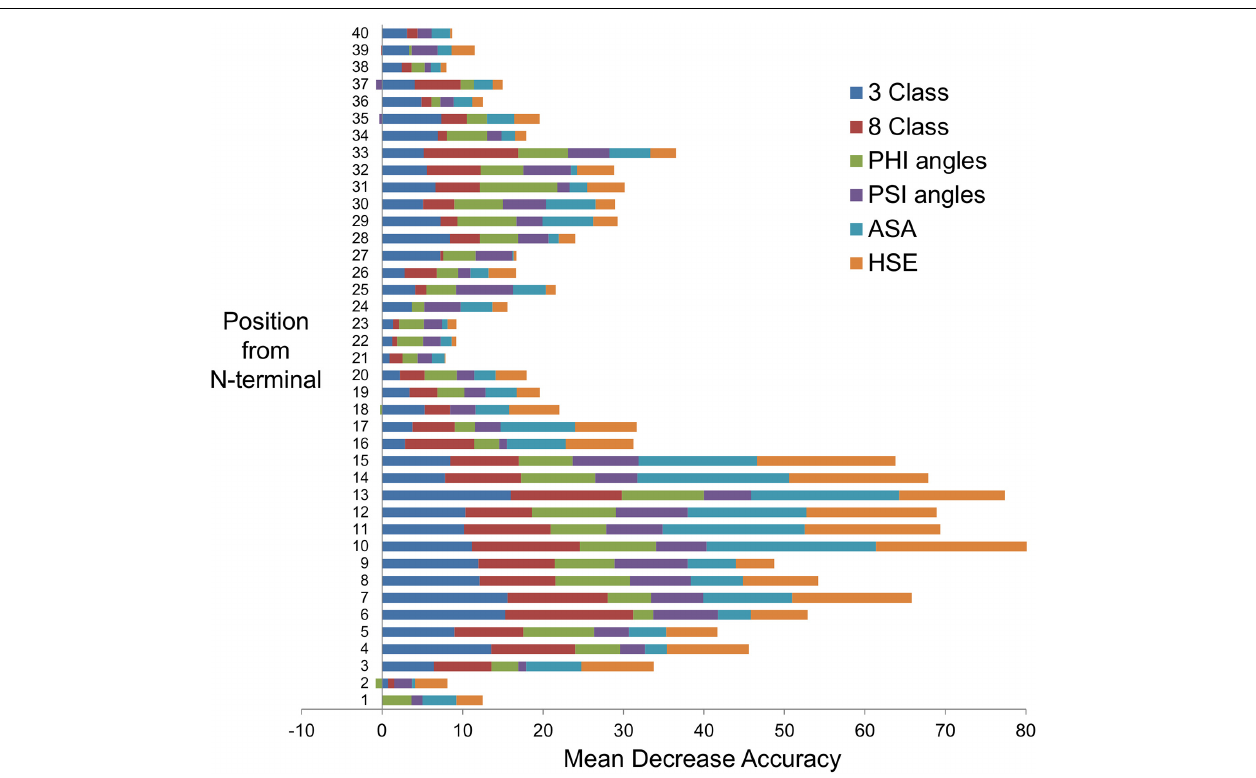
FIGURE 3 | Feature importance from secondary structure prediction methods. The bar chart shows the feature importance from each of the secondary structure prediction methods: 3 Class, three local conformational states; 8 Class, eight local conformational states; PHI angles, torsional (dihedral) angle φ (phi); PSI angles, torsional (dihedral) angle ψ (psi); ASA, solvent-accessible surface area; HSE, half-sphere exposure (upper). Position from N-terminal is equivalent to the amino acid number in a protein sequence. Each position is a machine learning input feature. There are 40 features in this example. The Random Forest algorithm has built-in feature importance function that computes ‘mean decrease accuracy’, which is based on how much the accuracy decreases when the feature is excluded, i.e., a measure of the feature contribution toward the Random Forest model’s prediction accuracy – the greater the contribution, the higher the importance.